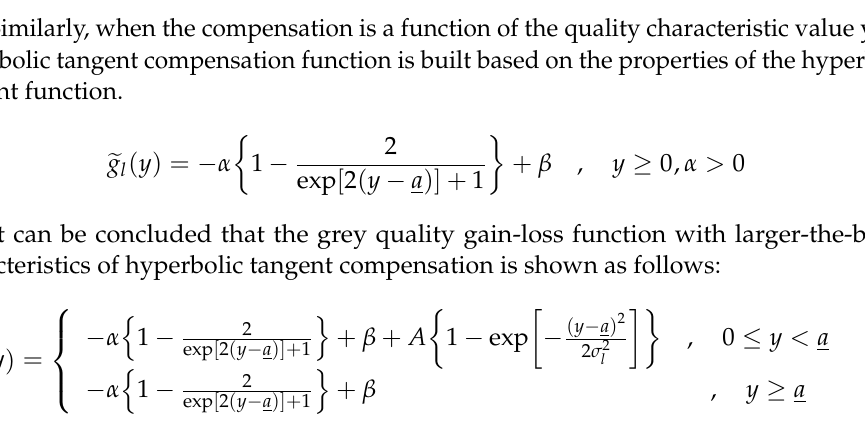
Figure 4. Grey quality gain–loss function curve with larger-the-better characteristics curve ( Grey quality gain-loss function curve with larger-the-better characteristics curve ( ) a =  (constant)). ( (cid:101) g l ( y ) = a l (constant)). l